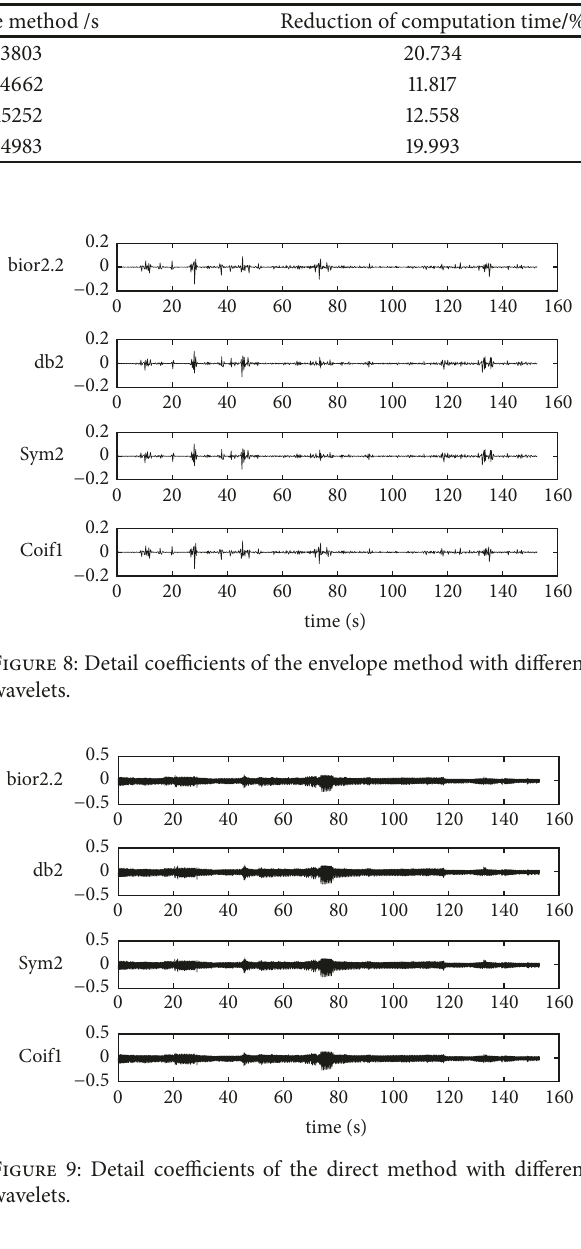
Table 6: Comparison of program computation time of the envelope method and the direct method.